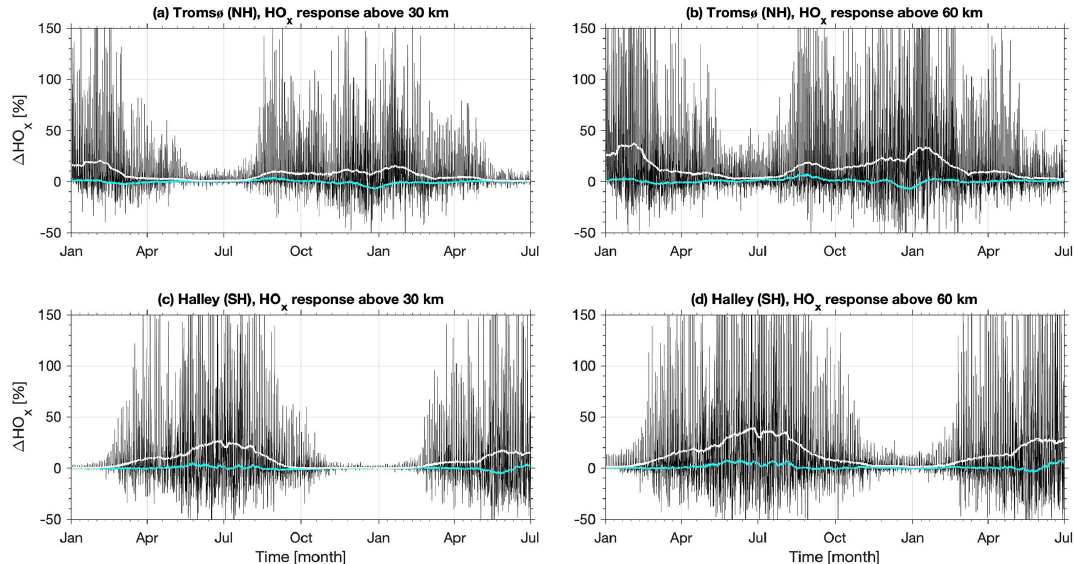
Figure 4. Height-integrated HO x response to PsA EEP at the Tromsø and Halley stations. (black line) The difference between the full-PsA and no-PsA simulations in 1h resolution. (white line) The 30d running mean of the black line (cyan line). The 30d running mean of the difference between thermo-PsA and no-PsA simulations.